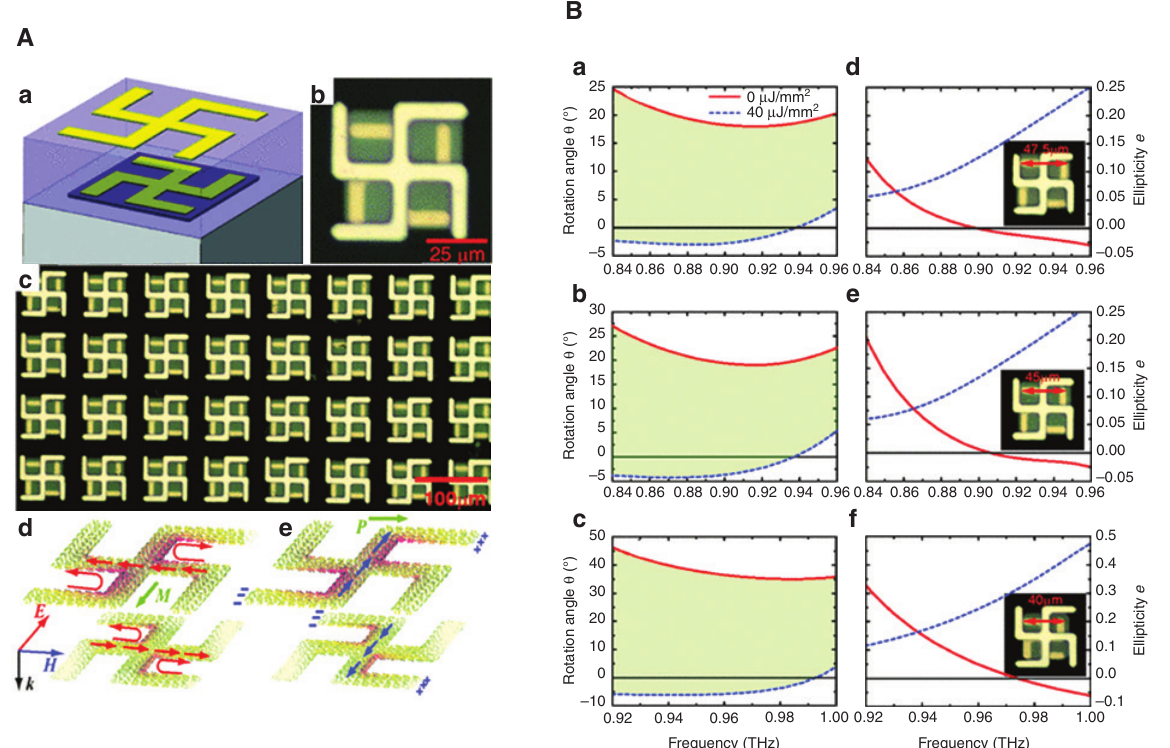
Figure 11: (A) Schematic of the unit cell based on the two controversial metallic designs separated by a dielectric spacer. The flow of the surface currents induced in the chiral metamaterial device and the induced magnetic (M) and electric (P) dipole momentum are also reported. (B) Dynamical characterization of the chiral device for different sizes of the bottom resonator. The rotation angles and ellipticities are reported when the laser was on (red line) and off (blue line). Reprinted figures with permission from Zhou J, Chowdhury DR, Zhao R. et al. Phys. Rev. B 86, 035448, 2012, Ref. [82], https://doi.org/10.1103/PhysRevB.86.035448. Copyright 2012 by the American Physical